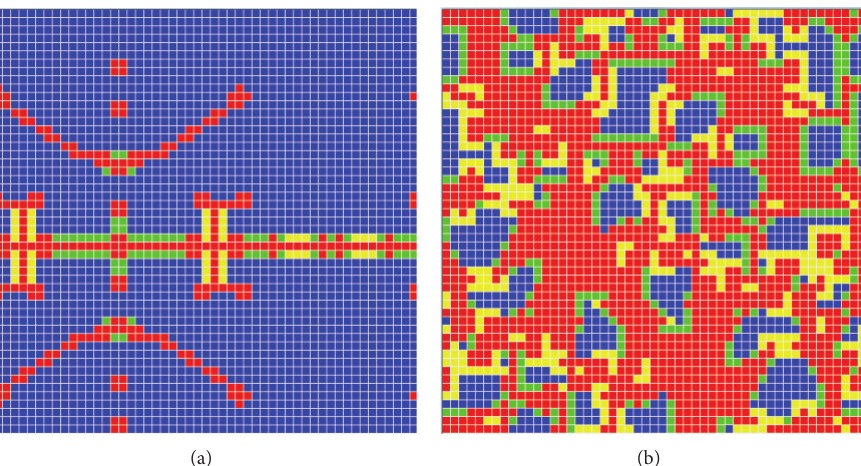
Figure 12: Simulation results on a 50 × 50 square lattice with Moore neighborhood and self-playing. The initial distribution of cooperators and defectors is randomly generated. The pattern in (a) is performed by the parameters region 𝑢 𝑖 0 > 𝑢 𝑖+2 1 (𝑖 = 4, 5, 6) , 𝑢 𝑖 0 < 𝑢 𝑖+2 1 (𝑖 = 1,2, 3) , 𝑢 5 < 𝑢 8 0 1 , and the pattern in (b) is by the region